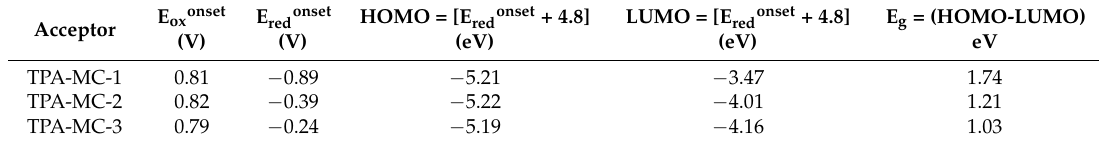
Figure 4. The respective cyclic voltammograms (CV’s) of TPA-MC-1, TPA-MC-2, and TPA-MC-3 recorded from dichlorobenzene solution at a scan rate of 50 µV/s. recorded from dichlorobenzene solution at a scan rate of 50 µ V/s. Table 2. Electrochemical properties of TPA-MC-1, TPA-MC-2 and TPA-MC-3. Table 2. Electrochemical properties of TPA-MC-1, TPA-MC-2 and